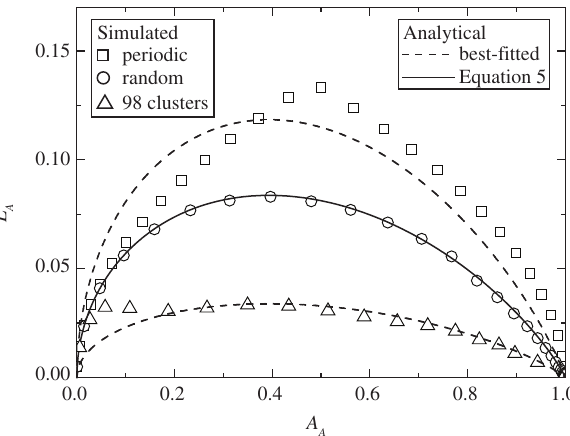
Figure 6. Area fraction against time, simulated by CA. Simulation data are force fitted by JMAK kinetics.